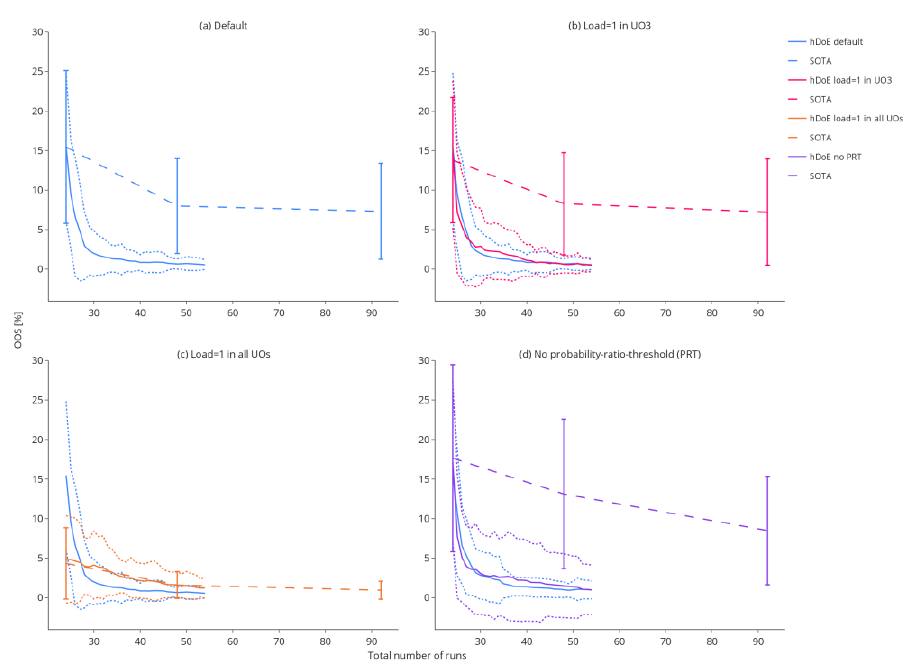
Figure 6. The decrease in OOS probability over the 30 hDoE steps for the different simulation scenarios. Each scenario was repeated 100 times. The solid line indicates the mean OOS probability, while the dotted lines show the standard deviation in the 100 repetitions of that step. For the reference method, OOS probabilities are plotted as dashed lines and were calculated at 24, 48, and 92 total runs.